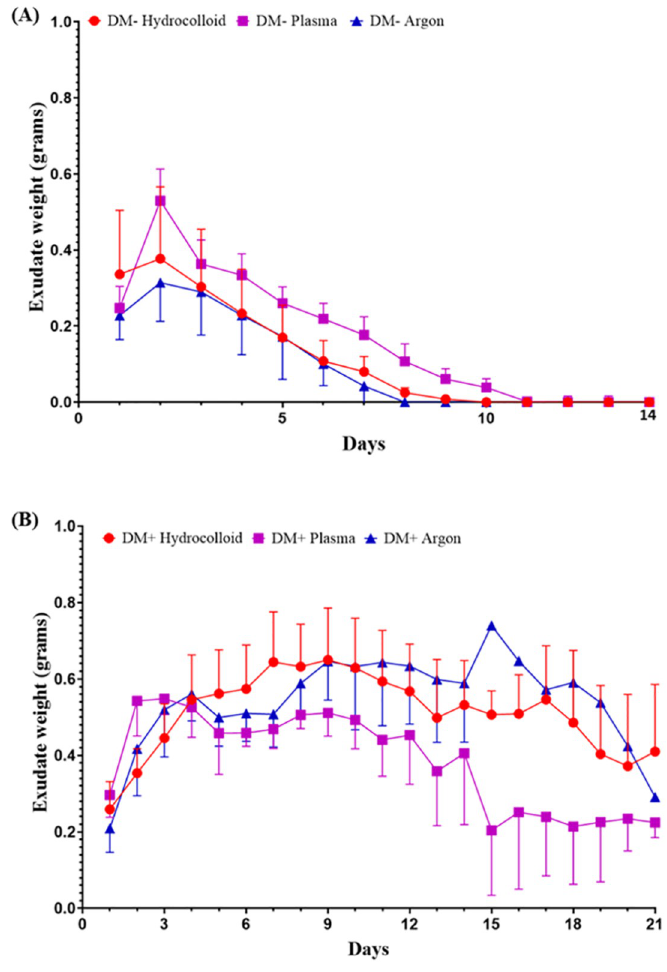
Fig 5. Exudate weights. Exudate weights in each group were recorded daily by measuring the weight (grams) of the hydrocolloid dressing. (A) Exudate weights in the DM- group are presented as the mean ± SD of ten wounds, and (B) exudate weights in the DM+ group as the mean ± SD of eight